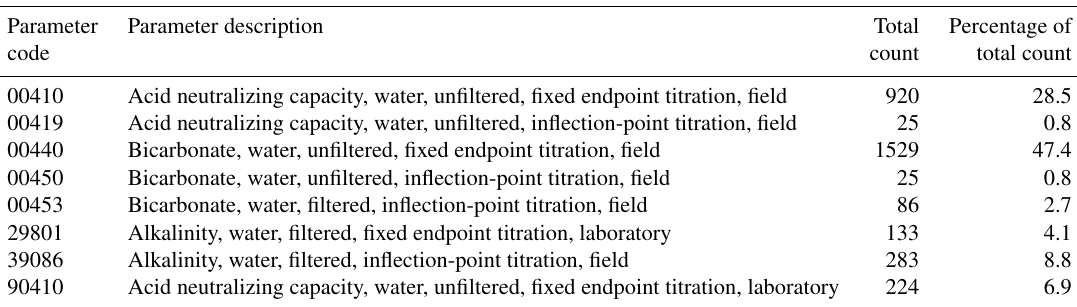
Annual average Table 4. USGS parameter codes used during analysis. Parameter Parameter description